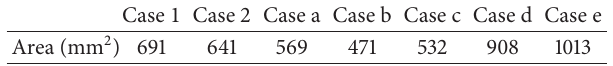
Table 2: Area in the lotus root cross section with von Mises stresses between 0.008 MPa and 0.012